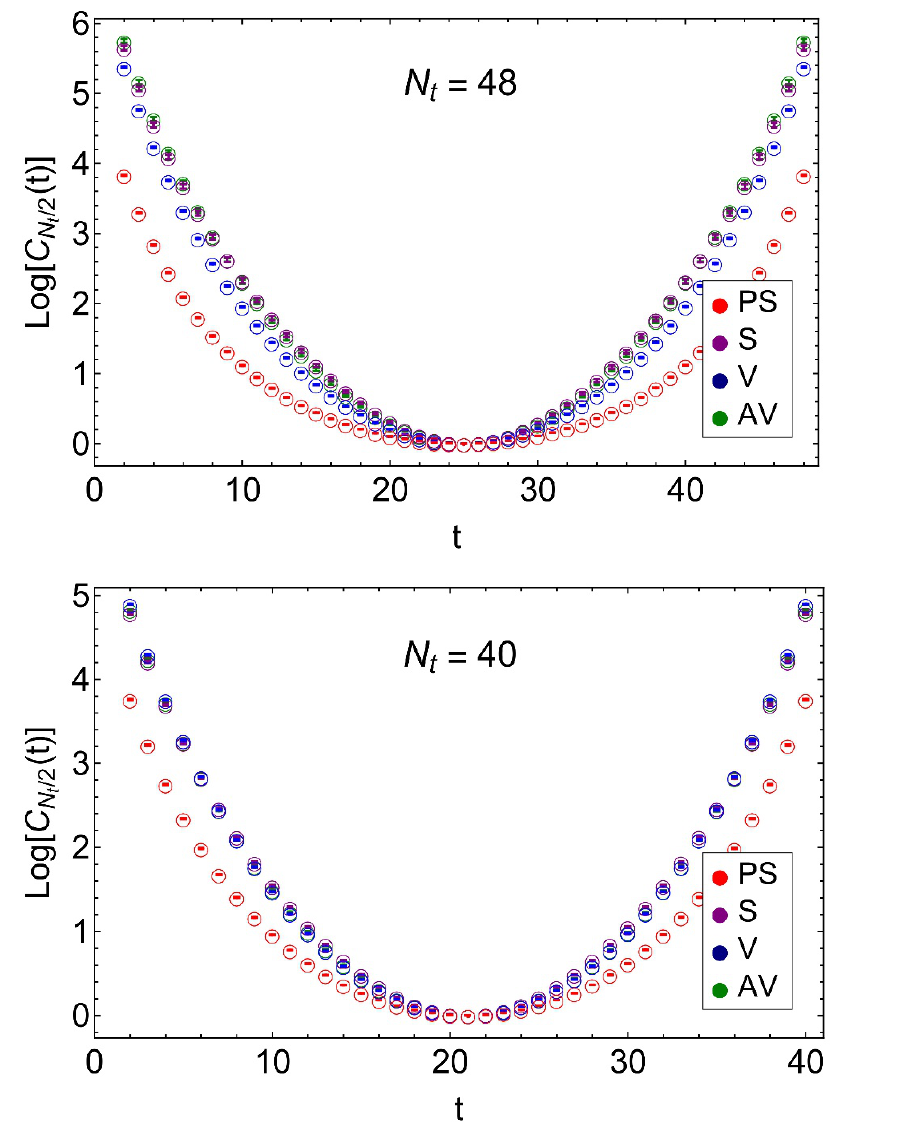
Figure 7 . Temporal correlation functions for pseudoscalar(red), scalar(purple), vector(blue), and axial vector(green) mesons. For a given Euclidean time t , we plot the logarithms of the correlation functions normalized by the correlation functions at N t =